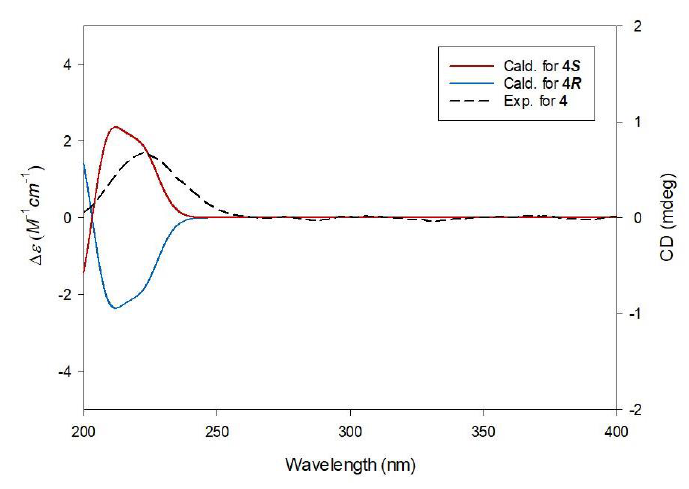
Figure 4. Experimental and calculated ECD spectra of 4 .